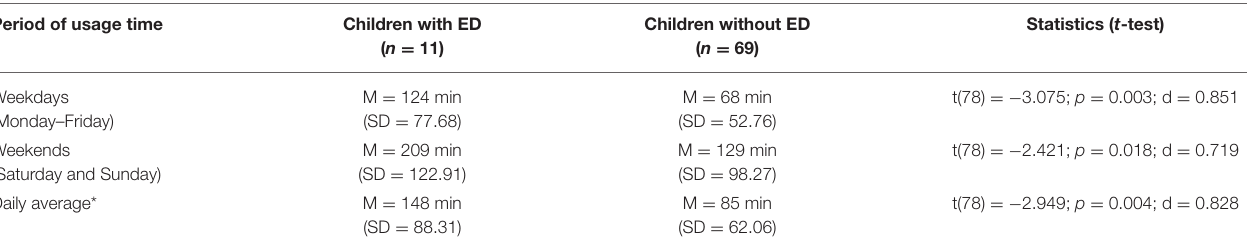
TABLE 5 | Differences in media usage time in minutes in children with ED and without